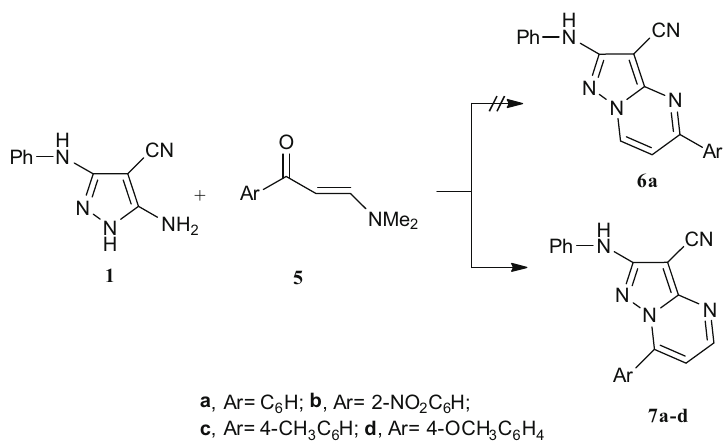
Scheme 2: The reaction of 5 - aminopyrazole derivatives 1 with enaminone derivatives 5 .